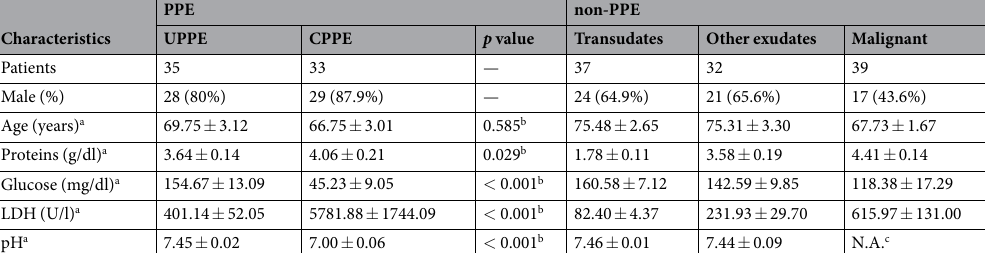
Table 2. Demographics and pleural fluid data of the study population. a Data are presented as mean ± s.e.m. b The p value of Mann-Whitney U test presents the difference between uncomplicated parapneumonic effusion (UPPE) and complicated parapneumonic effusion (CPPE). c N.A. means data not